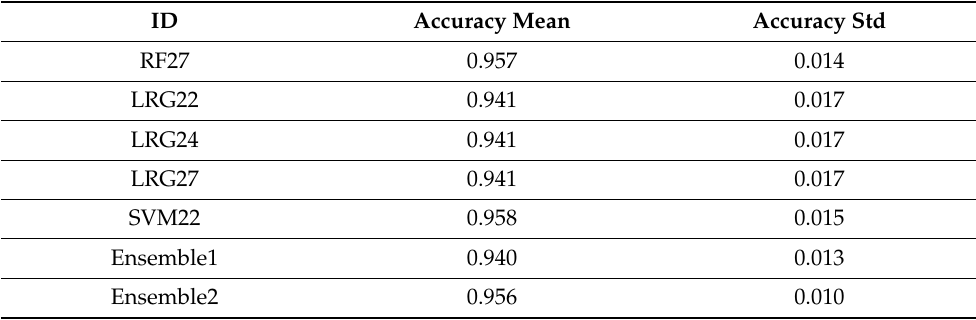
Table 1. Validation results of selected individual and ensemble